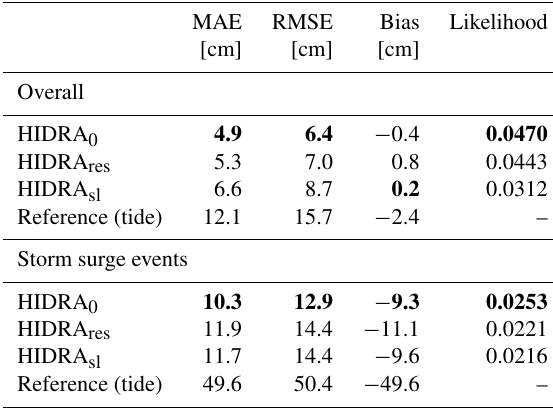
Table 3. Performance evaluation of different HIDRA sea level input variants. Results are reported for the entire test set (2014–2016) and separately for storm surge events. The best result in each category is denoted in bold.